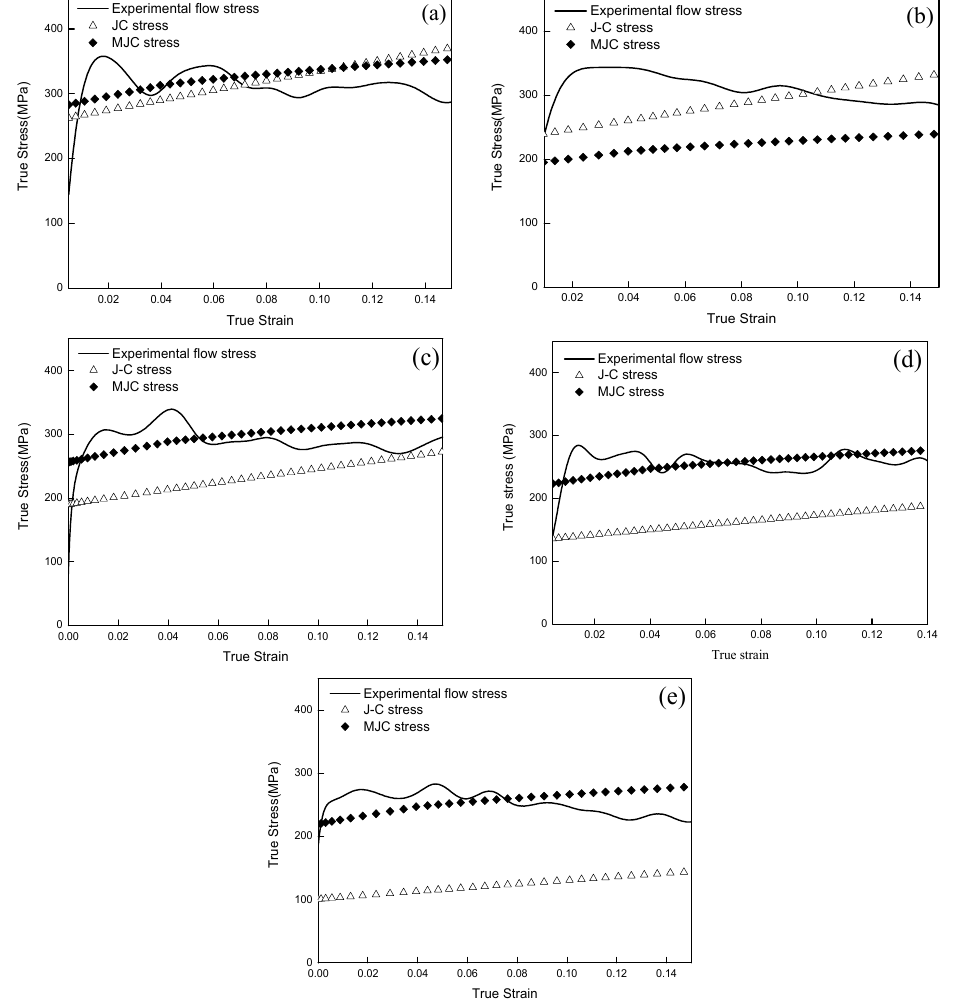
Figure 8. Comparison between experimental and predicted stress at ( a ) 100 °C; ( b ) 200 °C; ( c ) 300 °C; ( d ) 400 °C; ( e ) 450 °C.